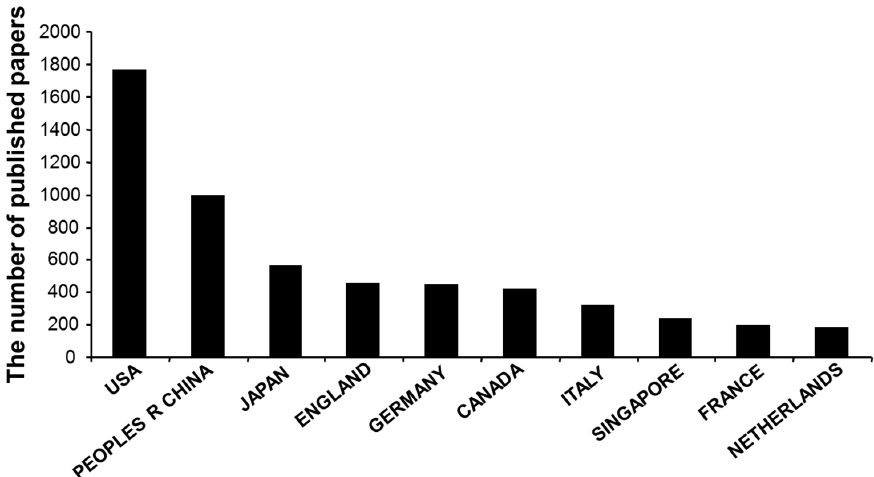
Figure 3. The most prolific countries with H 2 SBM research publications. Table 2. The top 10 most productive institutes in H 2 SBM research.